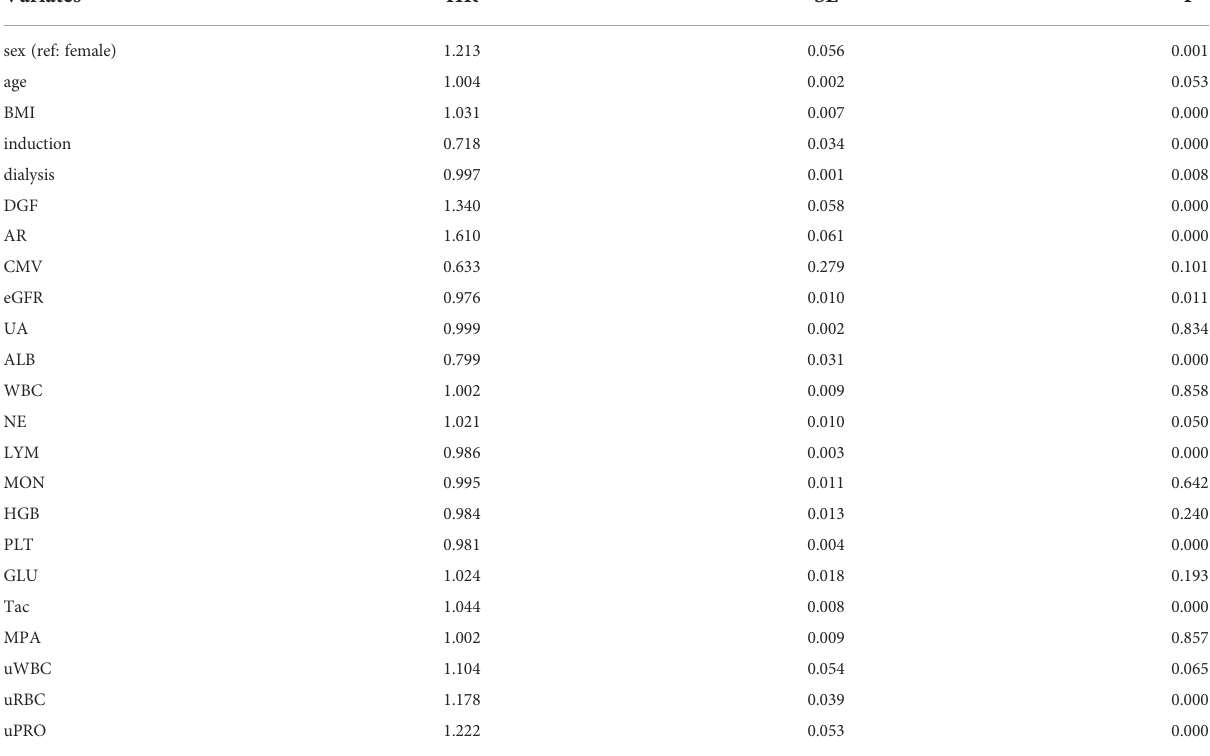
TABLE 2 Results of univariable time-dependent Cox